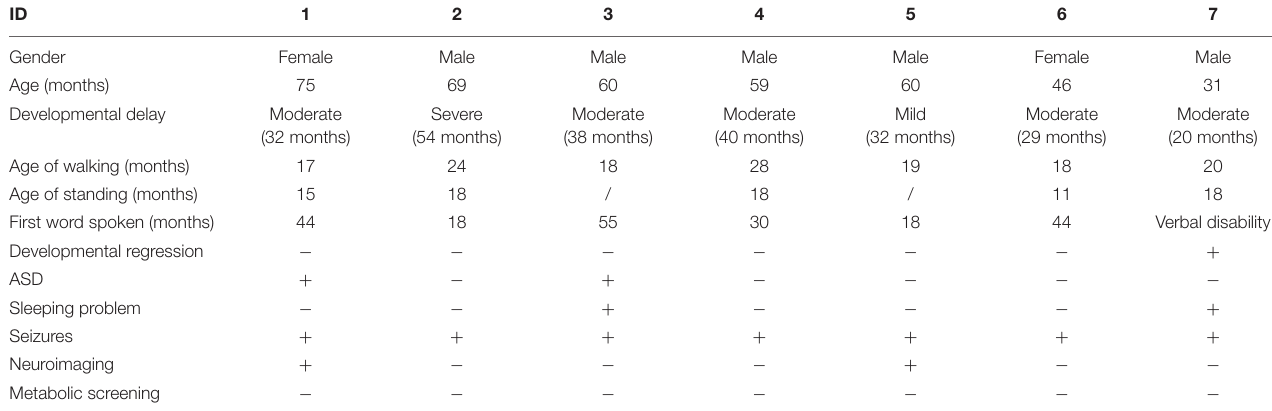
TABLE 1 | Clinical information of seven patients in our cohort.